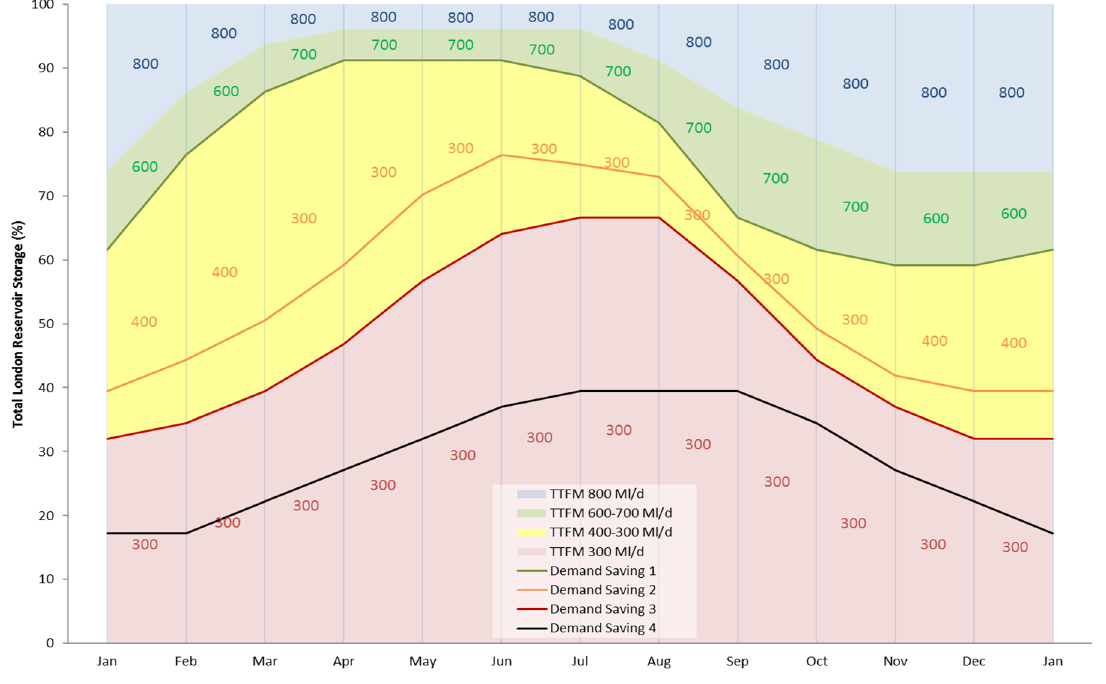
Figure 1. The Lower Thames Control Diagram (LTCD).